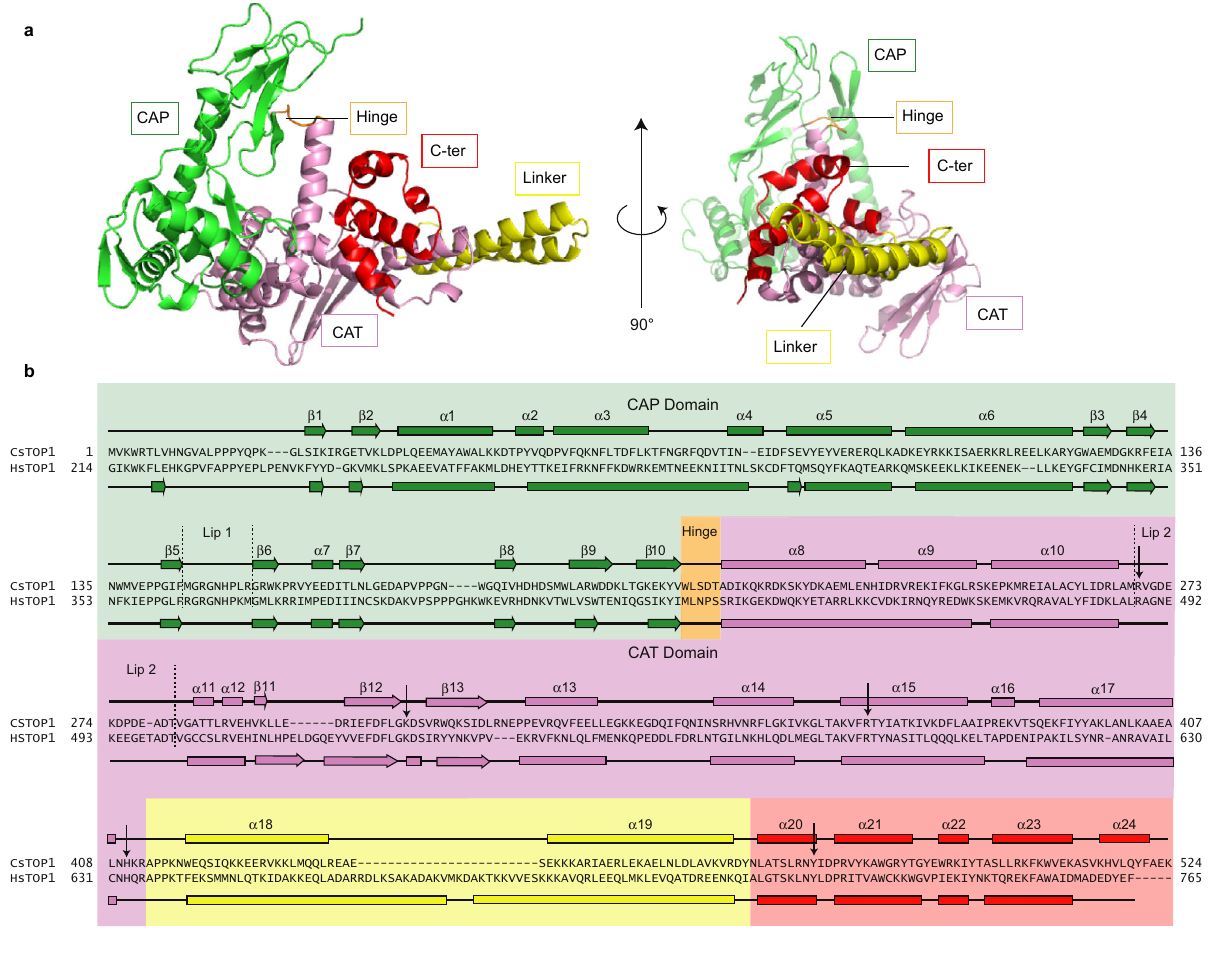
Fig. 2 Crystal structure of archaeal CsTOP1. a Open conformation of CsTOP1 solved by crystallography. b Sequence alignment between CsTOP1 and HsTOP1. The position of the lips are indicated with dotted lines. The residues interacting with DNA are shown with arrows. The coloring scheme is the same as in Fig. 1, apart from the Hinge loop which is shown in